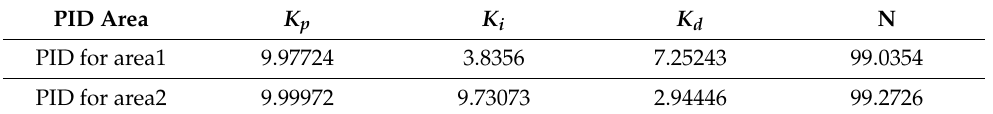
Table 4. Optimal parameters of PID controller parameters considering RESs penetration.